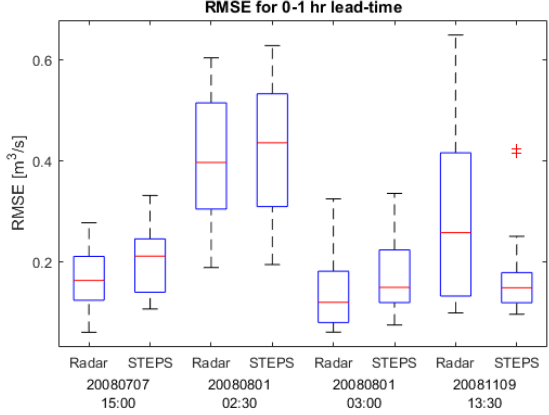
Figure 13. Flows ( a ) and peak flows ( b ) peak flows for events on 1 August 2008 starting at 02:30 and flows ( c ) and peak flows ( d ) for events on 1 August 2008 starting at 03:00. Q F Ens Radar, Q F Ens STEPS , Q F Det , Q m , Q G and Q R are, respectively, forecasted STEPS ensemble flows, forecasted deterministic flow, measured flow, estimated gauge flow and estimated radar flow.